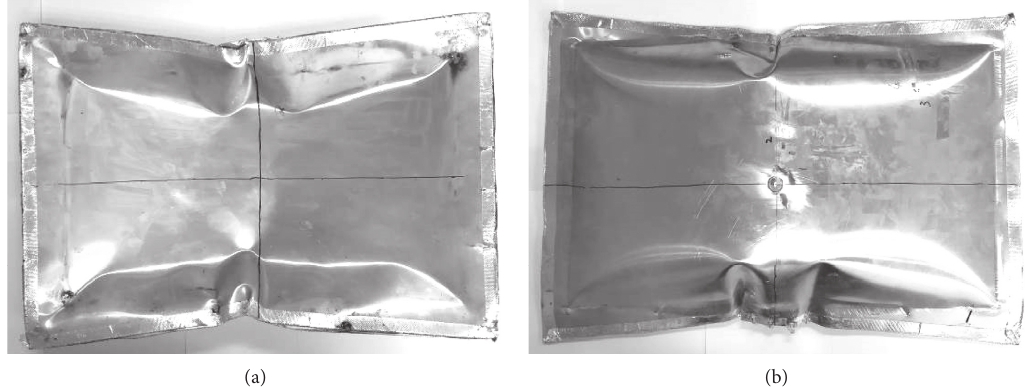
Figure 11: Front view of ST1 deformation. (a) Explosion-facing panel. (b) Explosion-back panel.